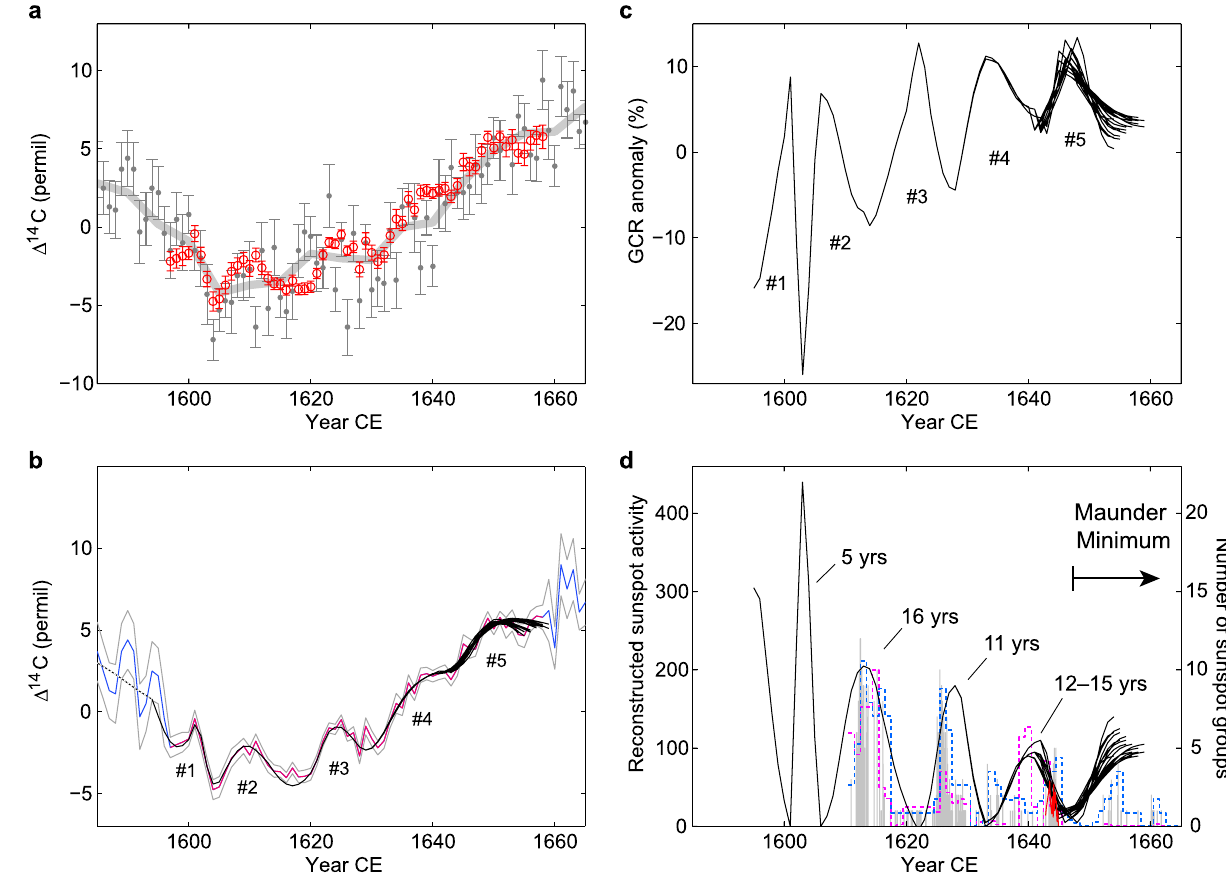
Figure 3. Carbon-14 record and the reconstructed cosmic ray and solar activity cycles around the onset of the Maunder Minimum. ( a ) High-precision annual carbon-14 data obtained in this study (red circles) plotted with the previously obtained annual data by Stuiver et al. 21 (gray dots) and the 5-year resolution IntCal13 data by Reimer et al. 22 (gray, thick curve). ( b ) Variation of carbon-14 data used for the reconstruction of solar cycles. Red and gray lines are the high-precision data and their uncertainty ranges. Blue and gray lines are respectively the data and their uncertainty ranges obtained by Stuiver et al. 21 . The black lines show the modeled carbon-14 data that were most consistent with the data (for details on the dashed line, see “Methods” section and Fig. S3). ( c ) Reconstructed cosmic ray variations around the onset of the Maunder Minimum. ( d ) Reconstructed sunspot activity around the studied period (black lines), plotted with the number of yearly mean sunspot groups by Hoyt and Schatten 4 (pink dashed line) and Svalgaard and Schatten 5 (blue dashed line). Daily sunspot groups by Vaquero et al. 6 (gray line) and the monthly mean sunspot groups by Carrasco et al. 28 for 1642–1645 CE (red line) are also